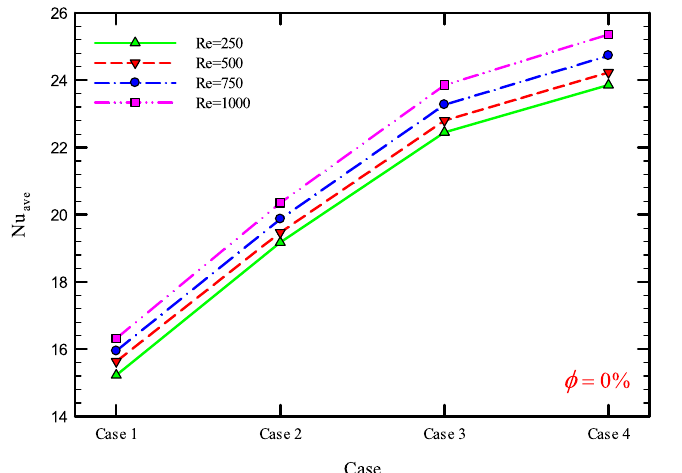
Figure 32. Nu ave for different cases for φ = 3%.